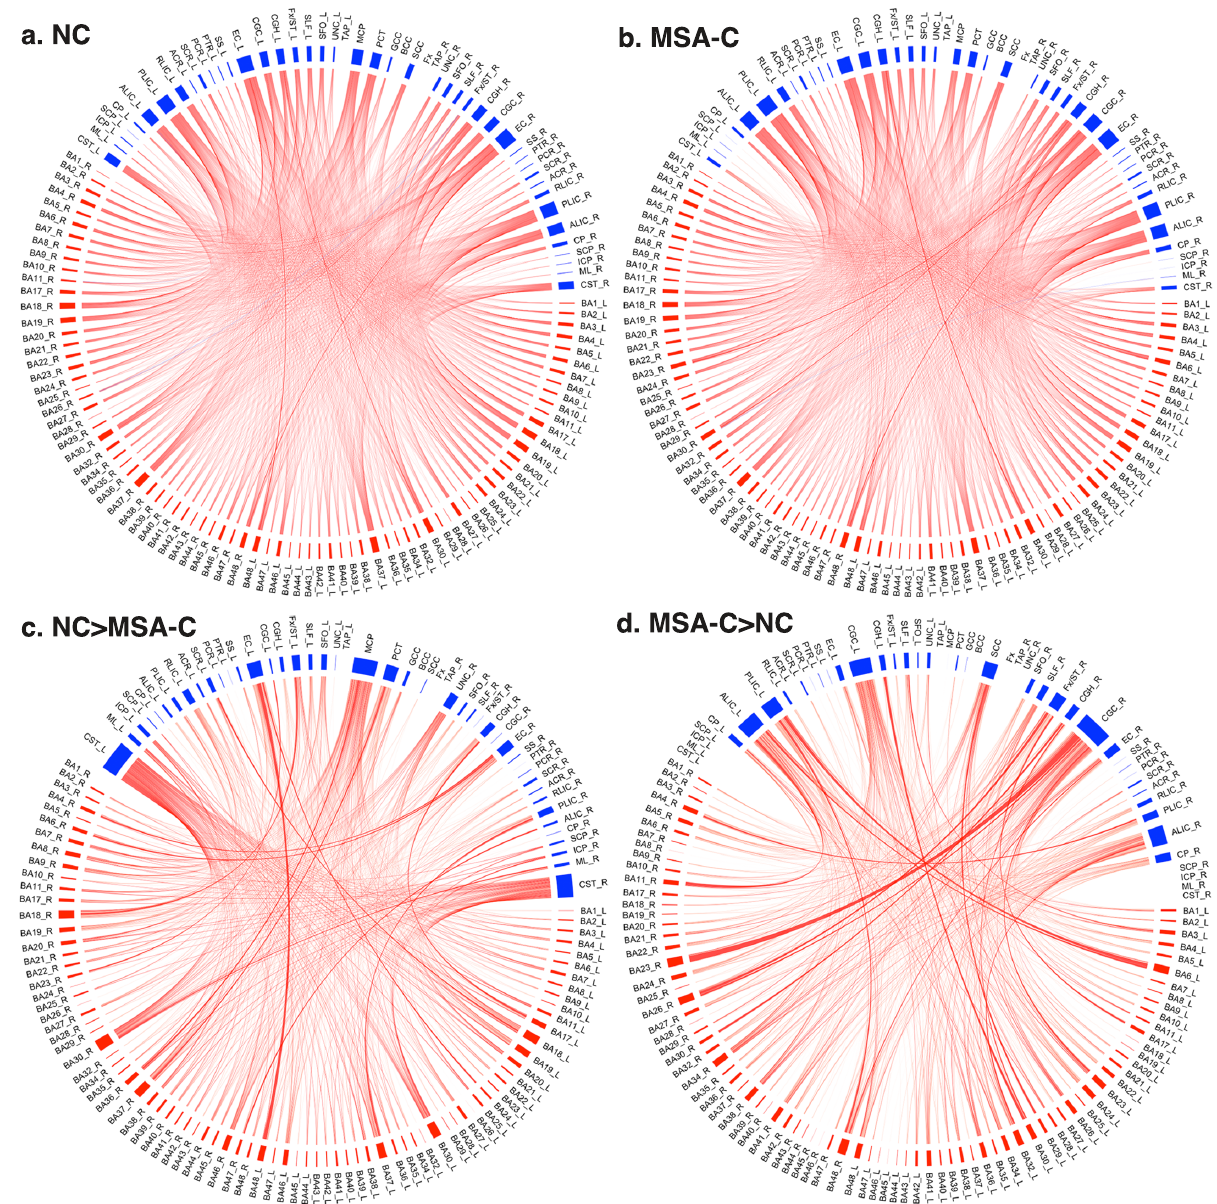
Fig. 1 Brain connectome of pairwise temporal correlations between parcellated WM bundles and GM regions. a Connectome of the NC group. b Connectome of the MSA-C group. c Connectome of differences between (A) and (B) where correlations in the NCs greater than those in the MSA-Cs. d Connectome of differences between a and b where correlations in the NCs smaller than those in the MSA-Cs. The WM bundles (denoted as blue boxes) are de fi ned using the JHU WM atlas, and the GM regions (red boxes) are parcellated using Brodmann ’ s de fi nitions. The thickness of the curve represents the strength of Pearson correlations in fMRI signals between a WM-GM pair, which is computed by averaging the correlation coef fi cients over the entire group (negative correlations are represented by blue curves, which are hardly visible due to their small values). It can be appreciated that, overall, WM has more and greater correlation differences in c than d , suggesting that the disease tended to impair functional signals in most of the WM bundles. See Supplementary Material A for the list of abbreviations for the WM bundles. Note that _L and _R means the left and right hemisphere